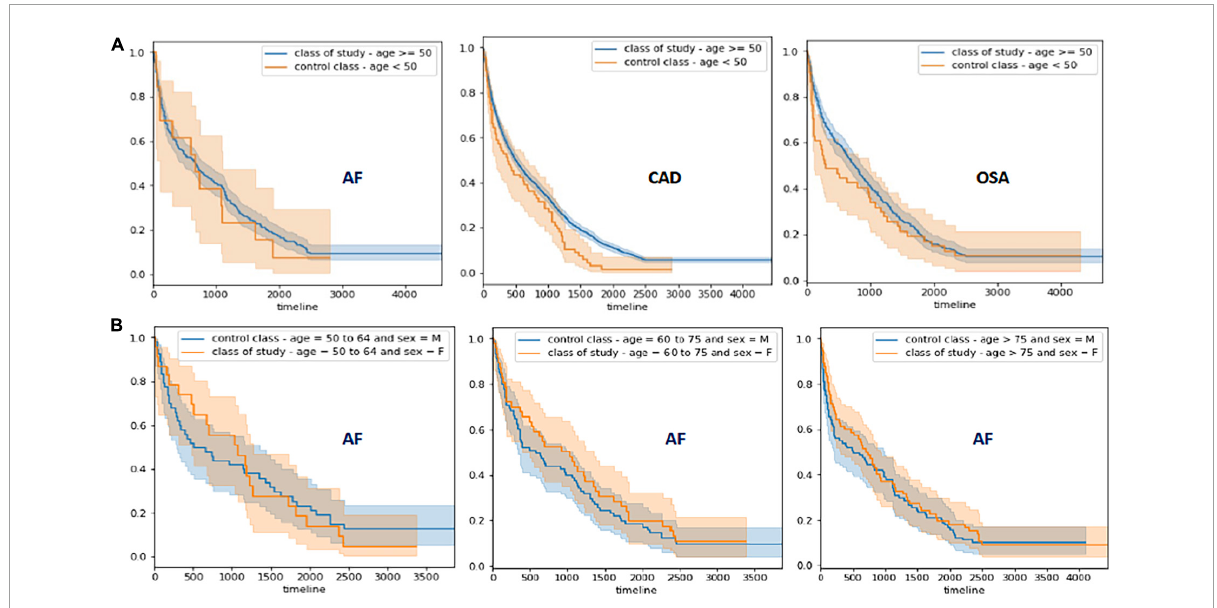
FIGURE2 Survival Analysis for AF, CAD, and OSA. (A) Survival analysis for AF, CAD, and SA. The blue line represents study cohort and orange line the control cohort. The shading areas (blue and orange) represent the confidence intervals for each cohort. (B) Survival analysis for risk of AF development comparing male and females by decades of life.